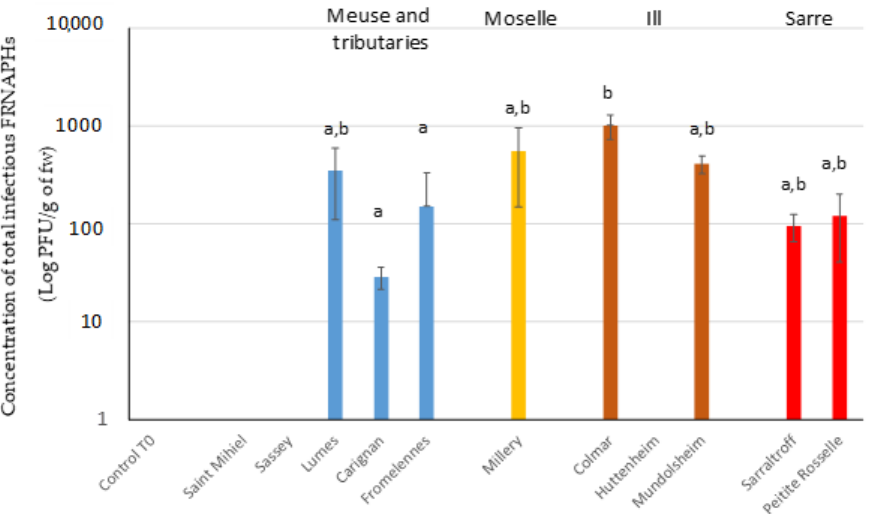
Figure 2. Concentrations of total infectious F-specific RNA bacteriophages (FNRAPHs) (mean ±SD, N = 3; PFU/g fw) quantified in the fresh weight (fw) of zebra mussel soft tissue before (control, T0) and after their introduction at the different sites for two months. Histograms marked with the same letter (a,b) are not statistically different at the 95% significance level.